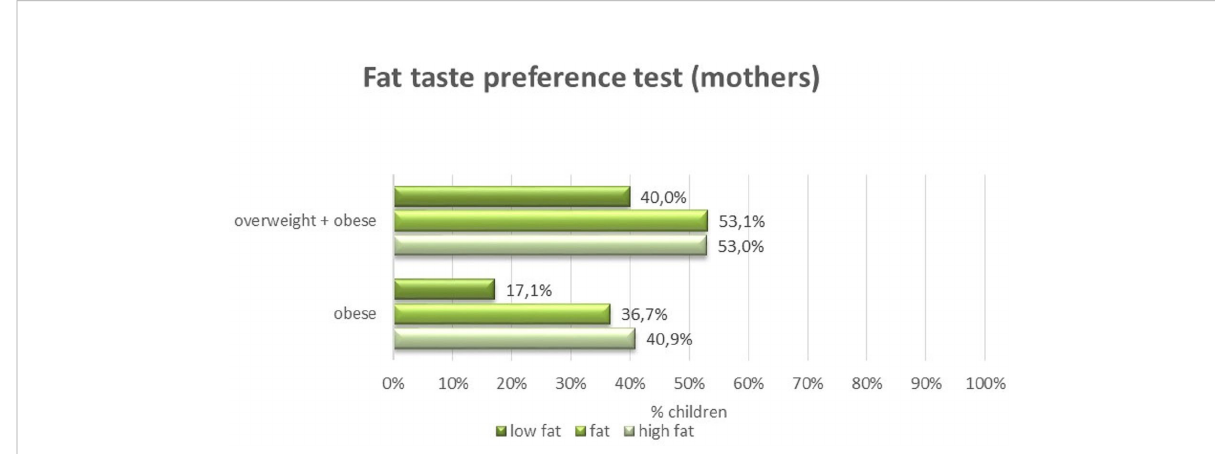
FIGURE 1 Preferences of the fat taste among mothers and the occurrence of overweight and obesity among children.